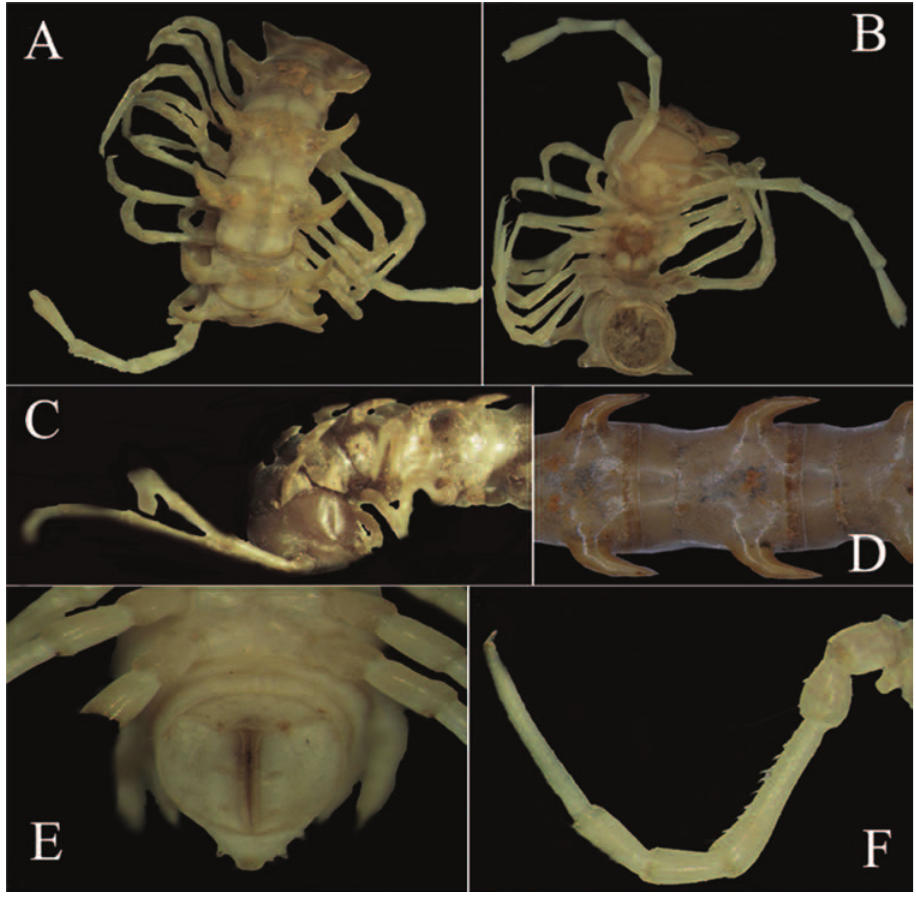
Figure 1. Desmoxytes eupterygota sp. n., ♂ paratype from near Tianhe. A–C anterior part of body, dorsal, ventral and lateral views, respectively D midbody segments, dorsal view e t elson, ventral view F midbody leg, front view. Photographed not to